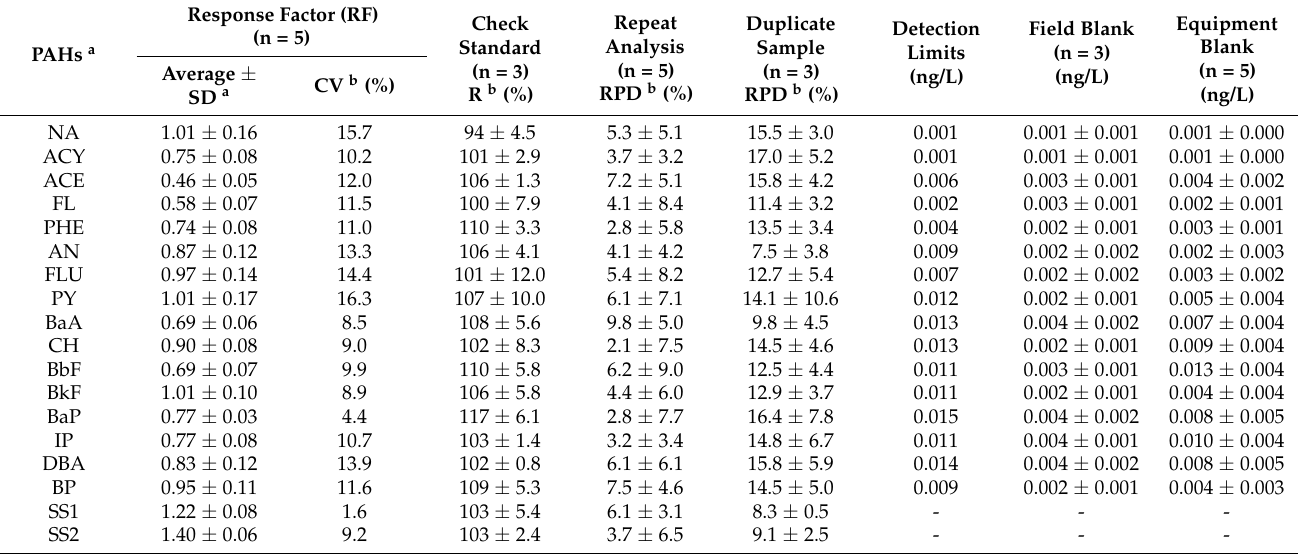
Table 3. Quality assurance and quality control for PAHs analysis in this